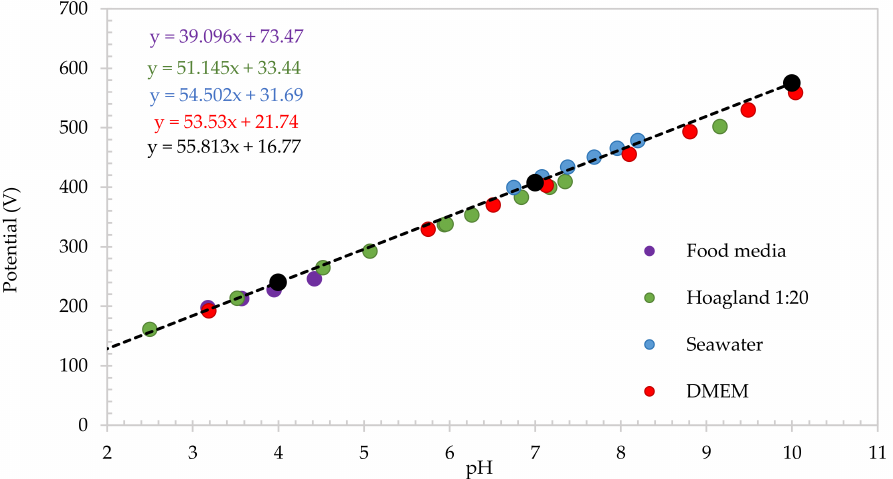
Figure 6. Calibration of electrodes based on subtracted values ( ∆ SA-Flav) in different medias and IUPAC standard buffers.